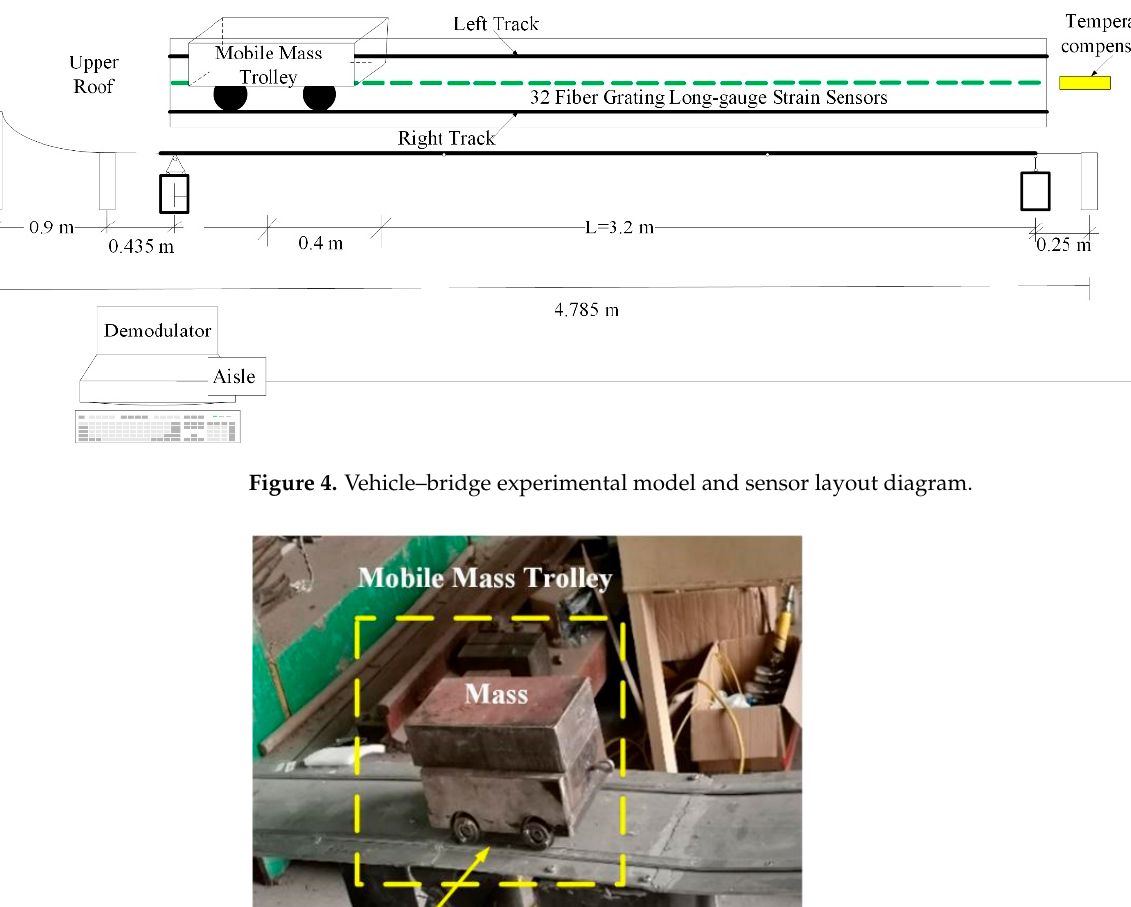
Figure 6. Sensor installation and experimental operation.